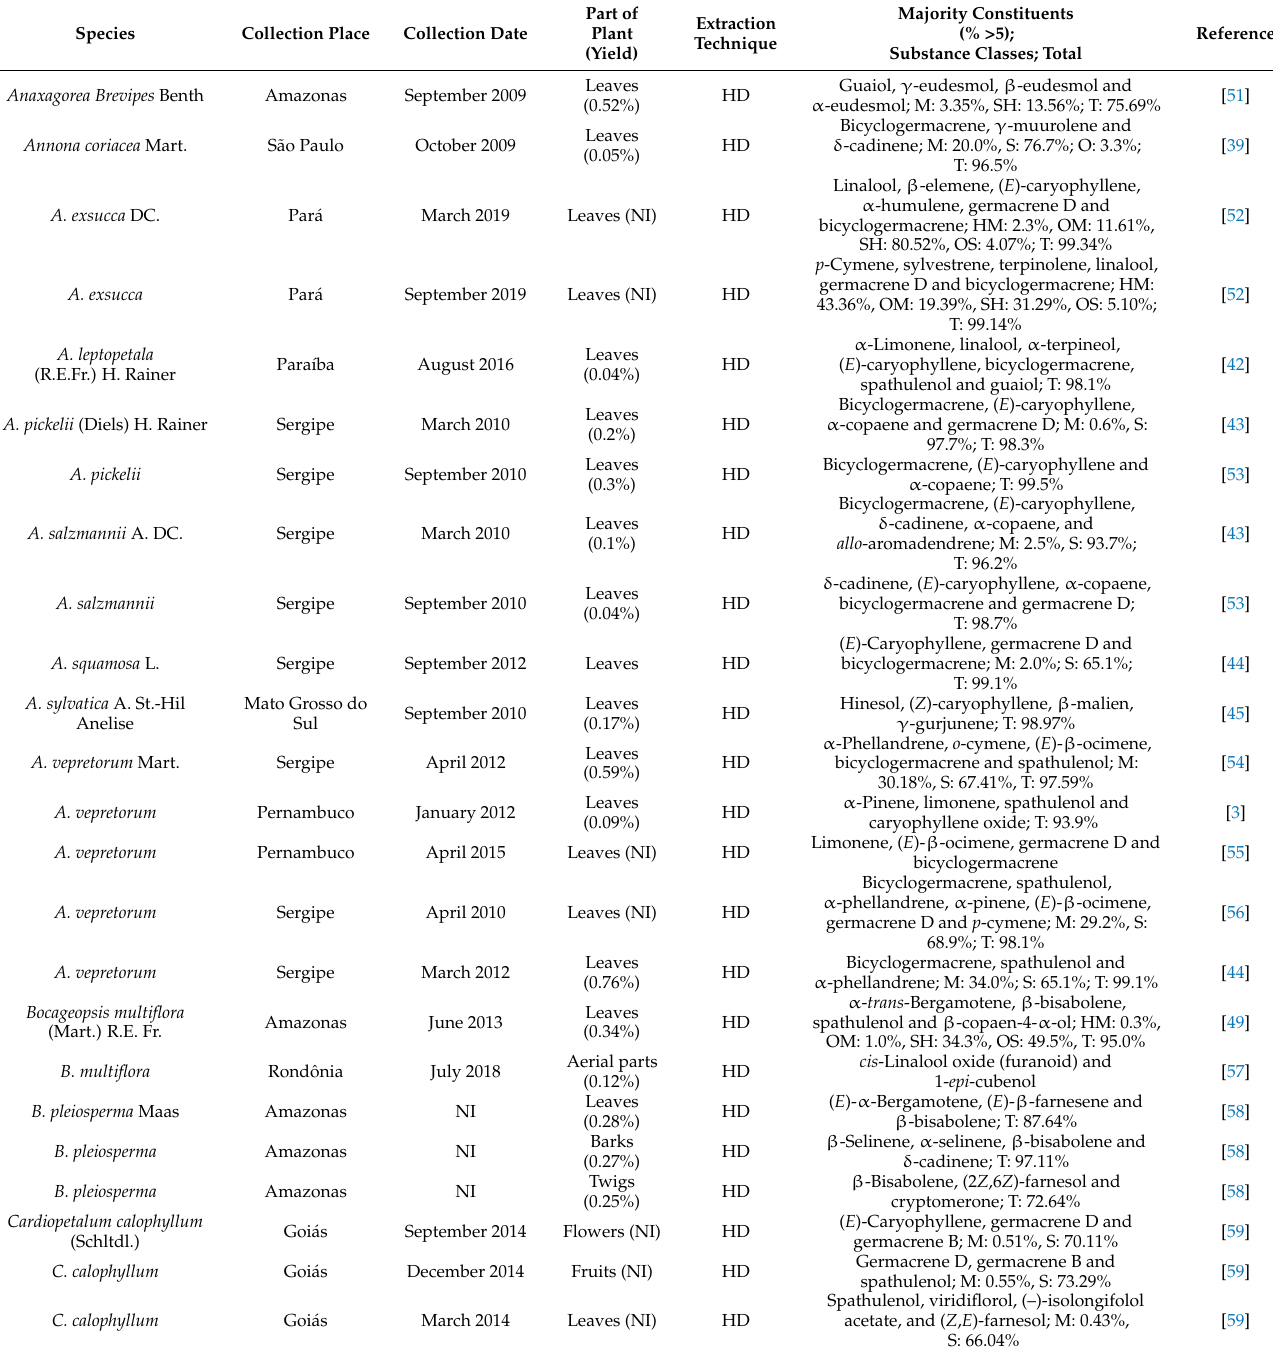
Table 2. Chemical composition of essential oils from Annonaceae species occurring in